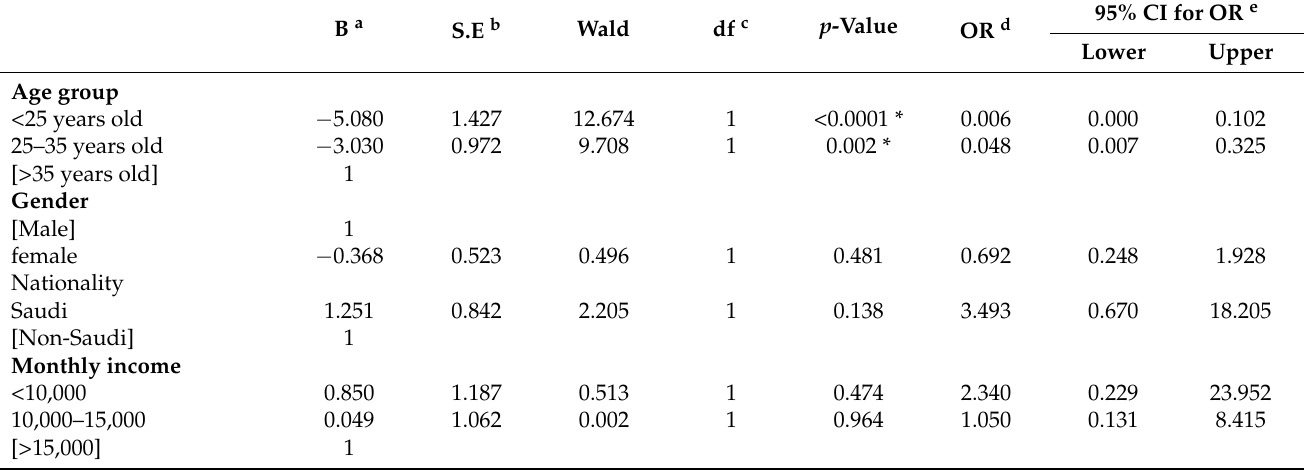
Table 6. Predictors of medication error among nurses from major hospitals in Jeddah, Saudi